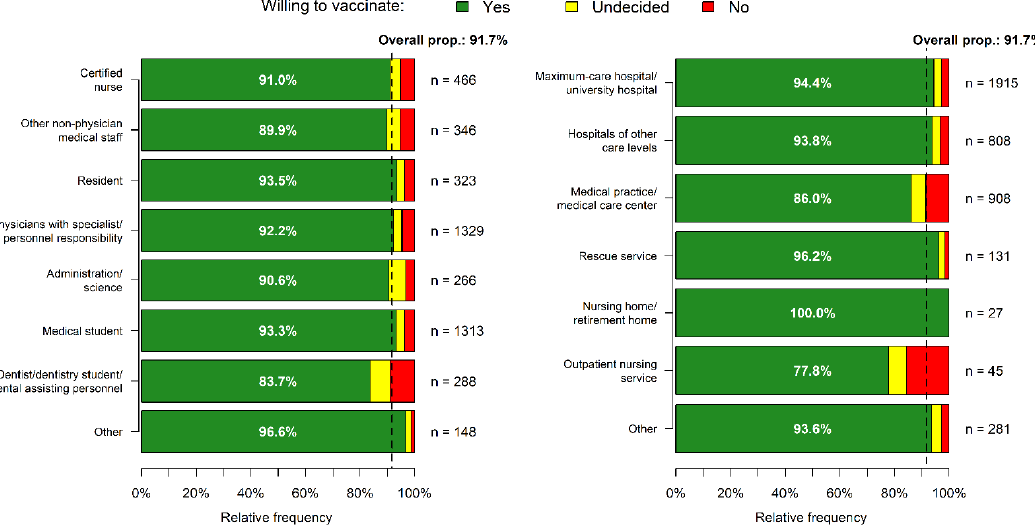
Figure 3. Vaccination acceptance in professional groups and work settings. The overall proportion of willing to be vaccinated was 91.7%. Abbreviations: prop., proportion.